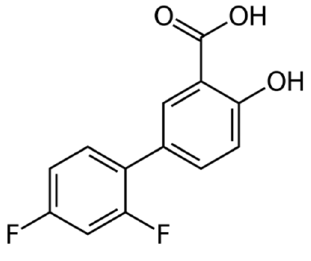
Figure 1. Structure of diflunisal.